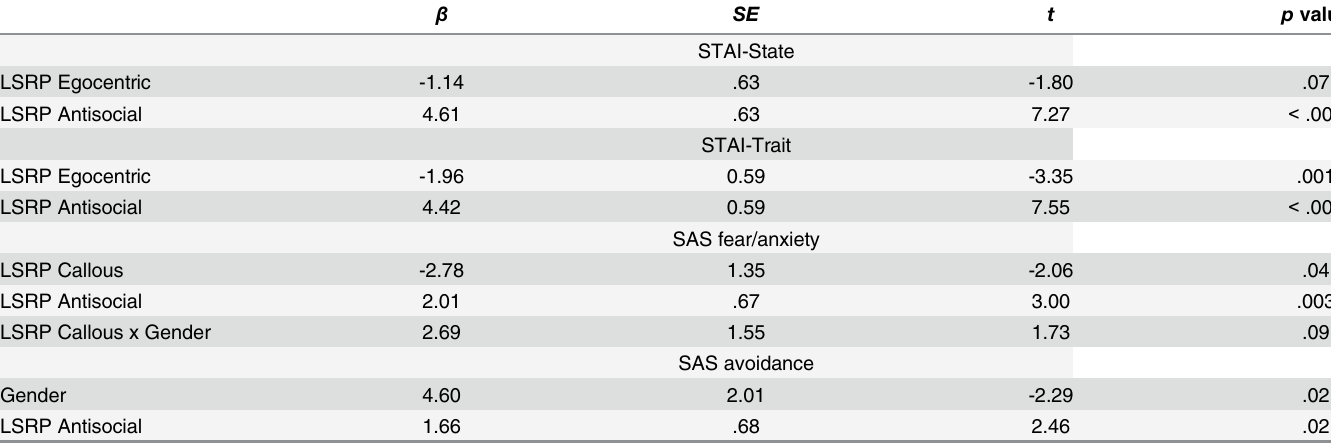
Table 2. Predictors of state anxiety, trait anxiety, social fear/anxiety, and social avoidance in an undergraduate